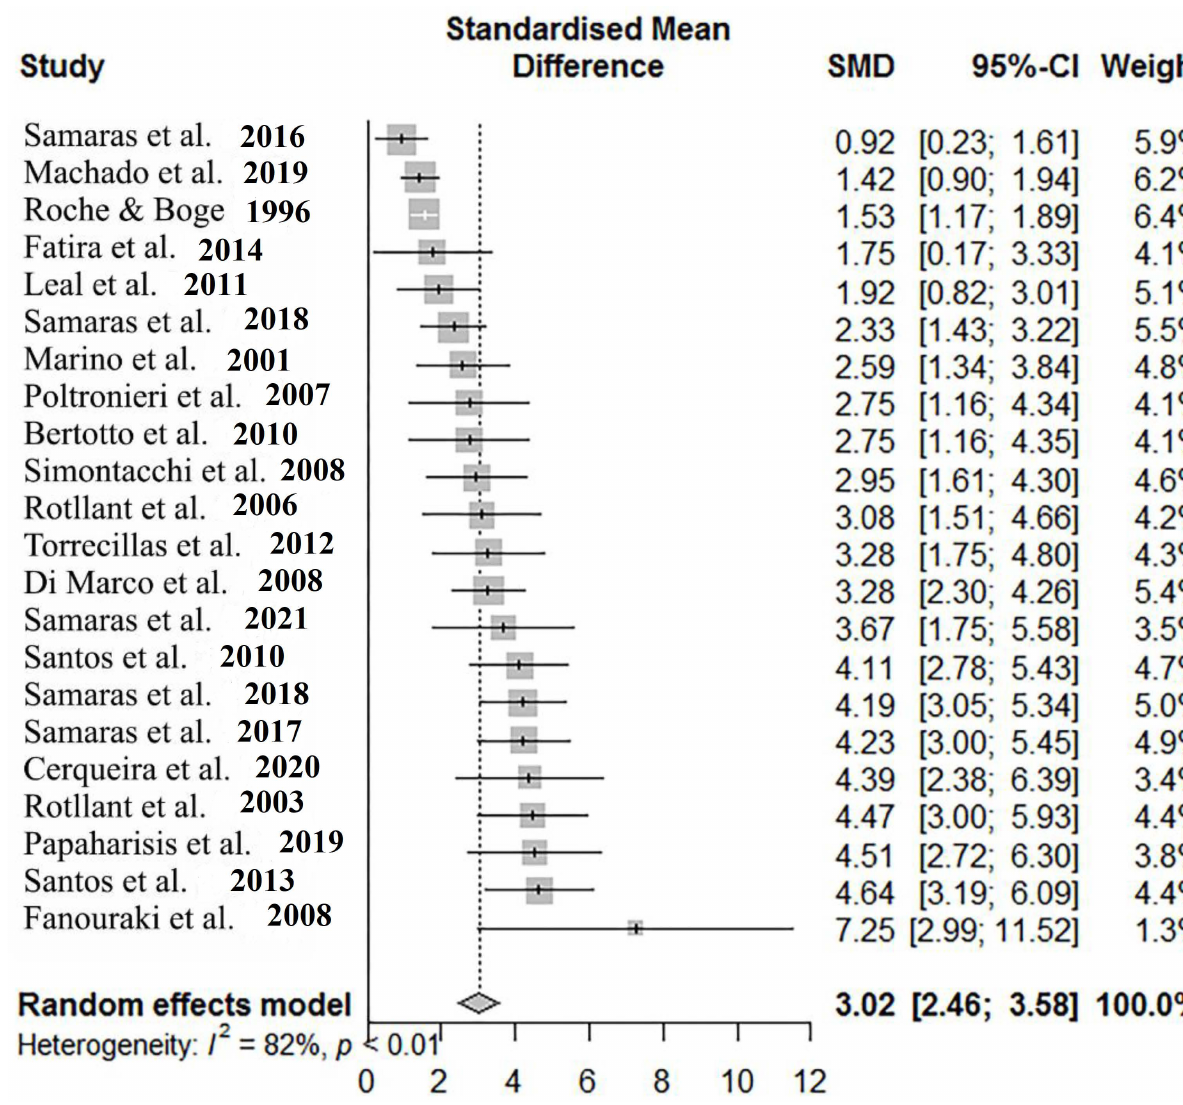
Figure 3. Forest plot depicting the SMD, 95%-CI, and weight of each study included in the analysis. Numbers in the brackets indicate the citation number of each study in the references section. Studies used in this meta-analysis are cited in the references